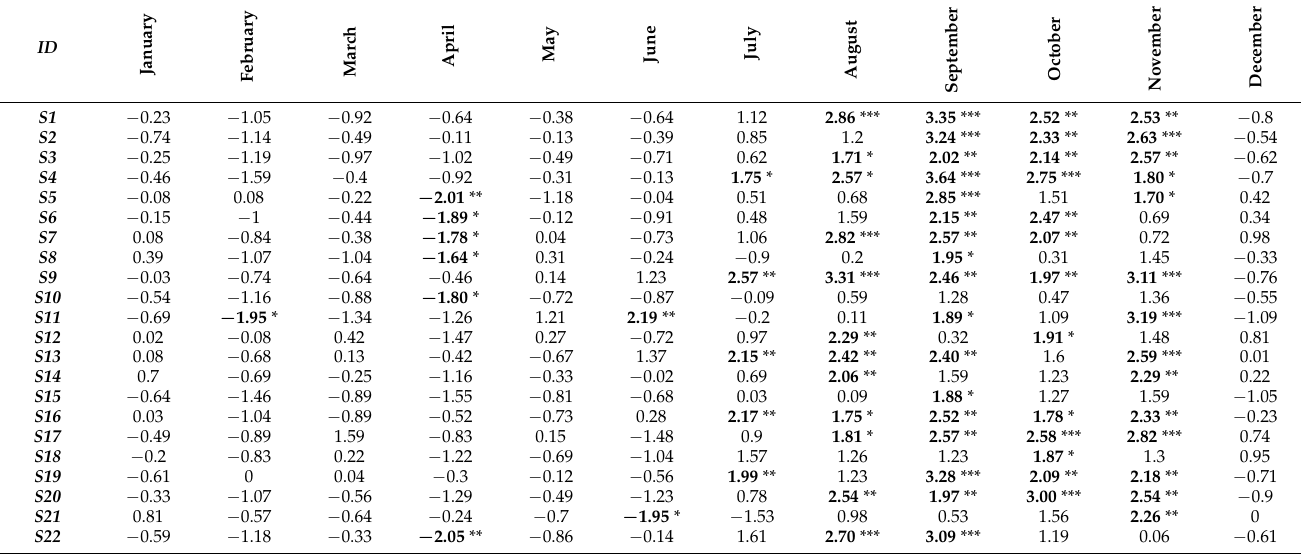
Table 2. Monthly precipitation trends of all data